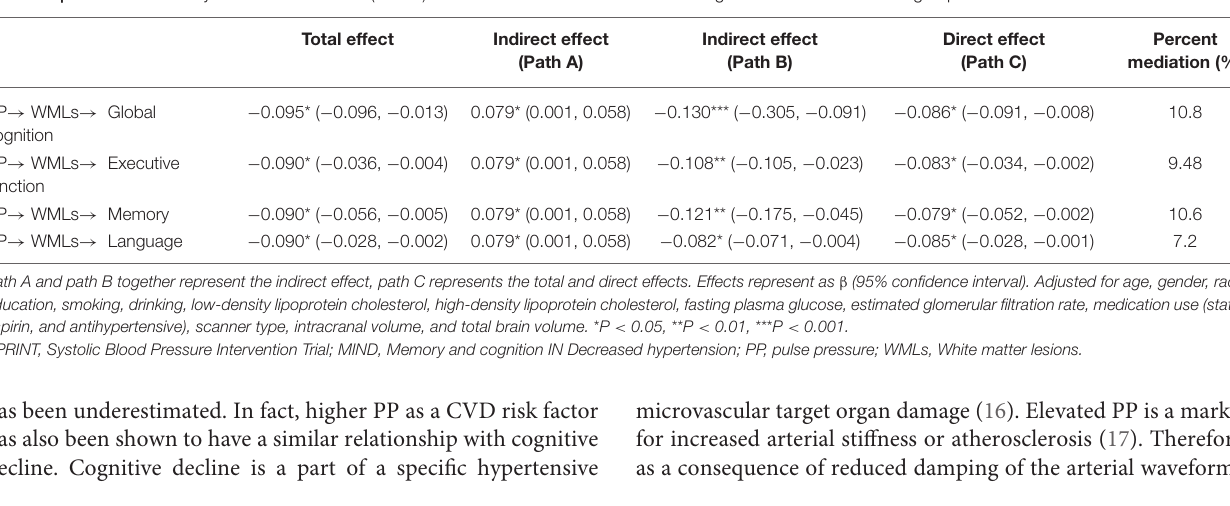
TABLE 6 | Mediation effect by white matter lesions (WMLs) in the association between PP and cognition in SPRINT-MRI